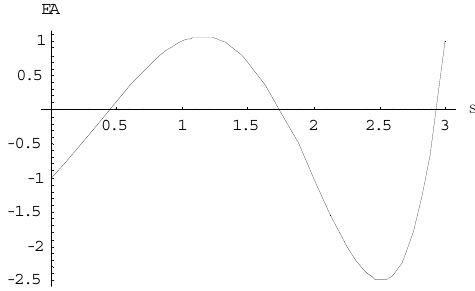
Figure 2. The dependence of the holes couple energy on the total spin.